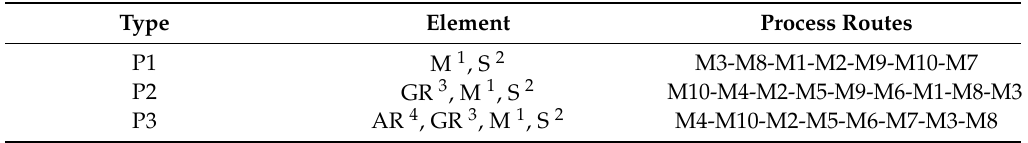
Table 7. Process route for assembly